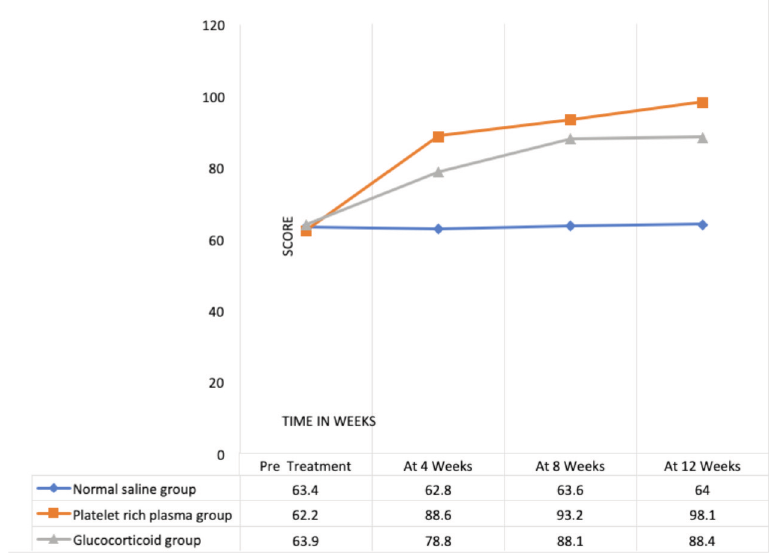
Comparison of mayo elbow performance score (MEPS), (pre-treatment and post infiltration of normal saline, L-PRP, Fig. 1: Glucocorticoid at follow-up visits of 4, 8, and 12 weeks).